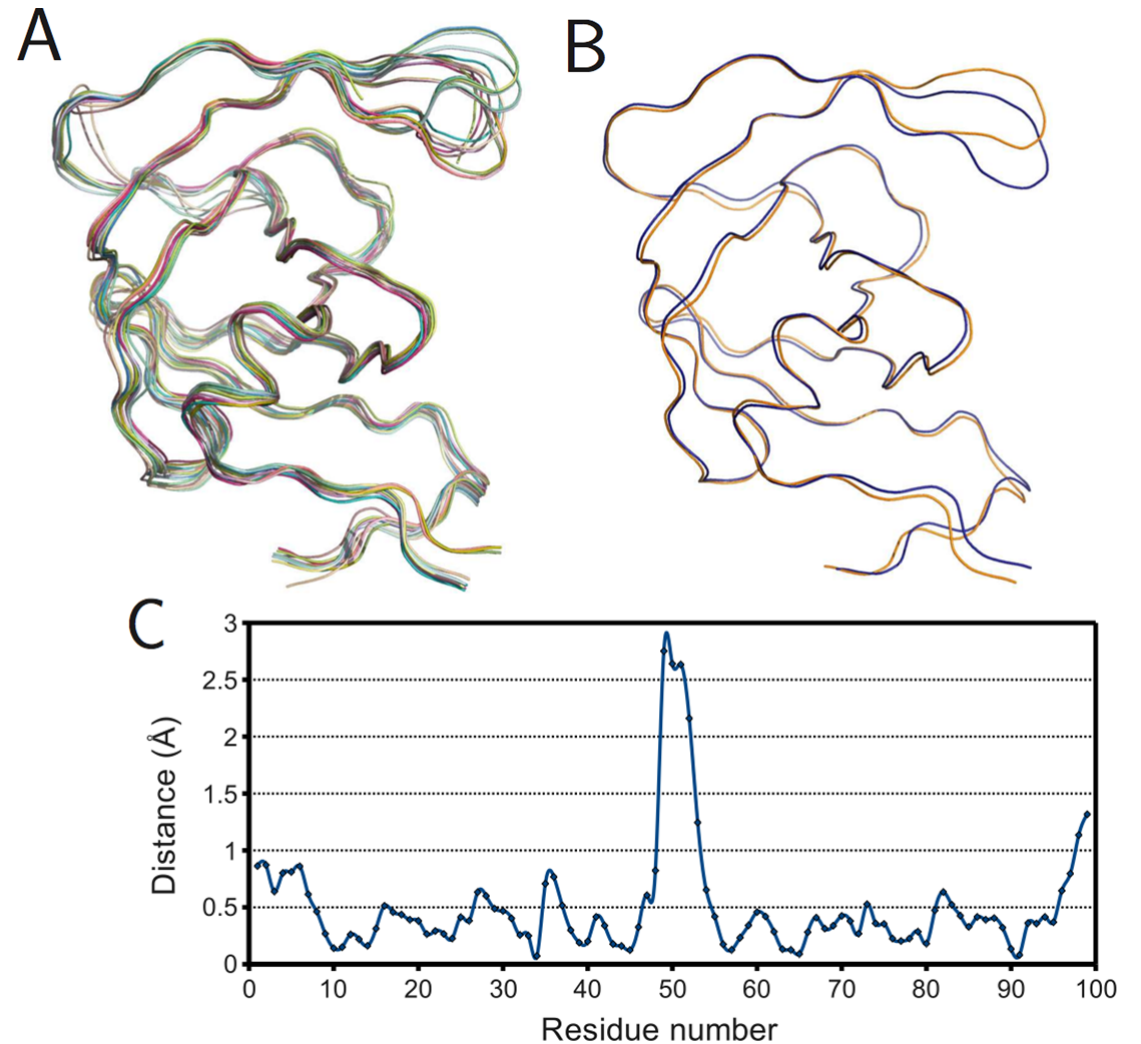
Figure 6. Ligand effects on PR monomer structure. (A) Superposition of ligand-free monomers; (B) superposition of mean ligand-free (orange) and bound (blue) monomers; (C) plot of spatial difference Vs residue number for mean ligand-free and bound monomers. Ribbon diagrams rendered using